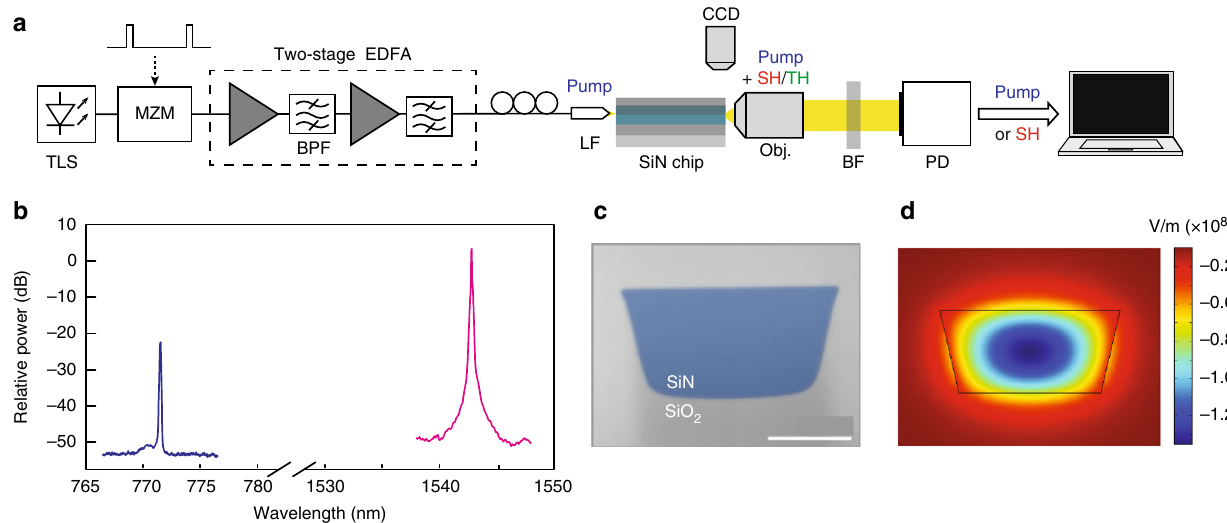
Fig. 1 Experimental setup and waveguides. a Experimental set-up. TLS, tuneable laser source; MZM, Mach-Zehnder modulator; EDFA, erbium-doped fi bre ampli fi er; BPF, fi bre band pass fi lter; LF, lensed fi bre; CCD, digital camera; BF, free-space block fi lter assembly; PD, power detector; SH, second harmonic; TH, third harmonic. b Pump (magenta line) and second harmonic (blue line) spectra at the waveguide output for a coupled peak power of 90 W, after the second harmonic growth. No signi fi cant pump broadening is observed. c Scanning electron microscope picture of a waveguide cross-section ( scale bar : 0.5 μ m). d Simulation of the pump pro fi le, injected on the fundamental transverse magnetic